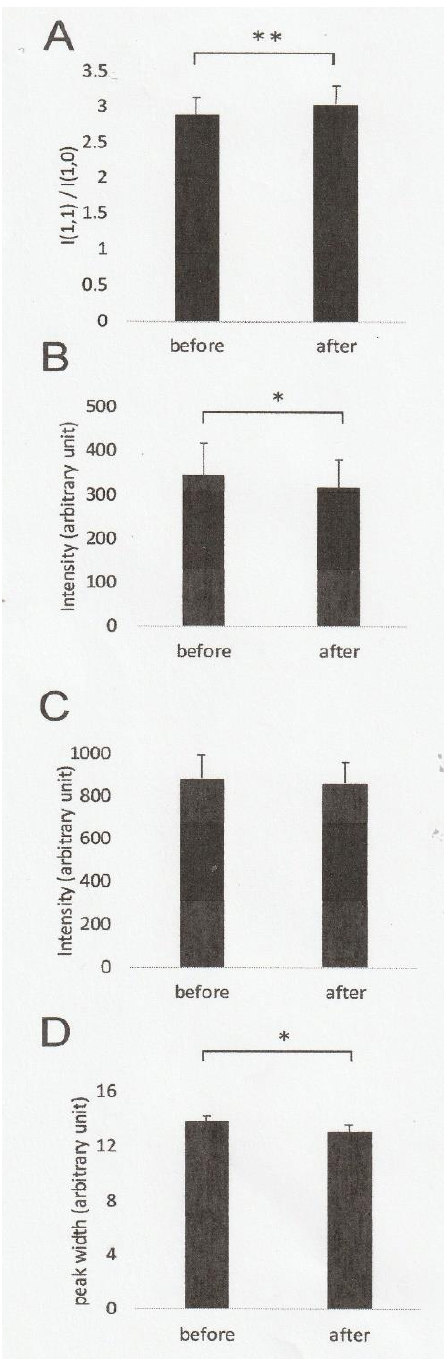
Figure 1. Changes in the equatorial reflections from high-Ca rigor fibers before and after ramp-shaped releases. ( A ) Mean values of the Intensity ratio, I (1,1)/I (1,0), obtained before (left) and after (right) application of ramp-shaped releases. ( B ) Mean values of the 1,1 reflection intensity, obtained before (left) and after (right) ramp-shaped releases. ( C ) Mean values of the 1,1 reflection intensity, obtained before (left) and after (right) application of ramp-shaped releases. ( D ) Mean values of half-width of the 1,0 reflection, obtained before (left) and after (right) ramp-shaped releases. In A–D, vertical bars indicate SEM, while horizontal bars with * and ** indicate significant differences with p < 0.05 and p < 0.01 ( t -test) between the corresponding mean values, respectively.